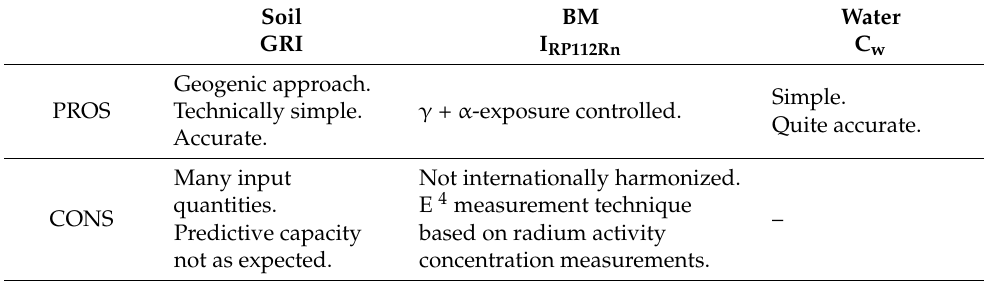
Table 2. Assessment of predictability and probability. Analysis of pros and cons of the selected